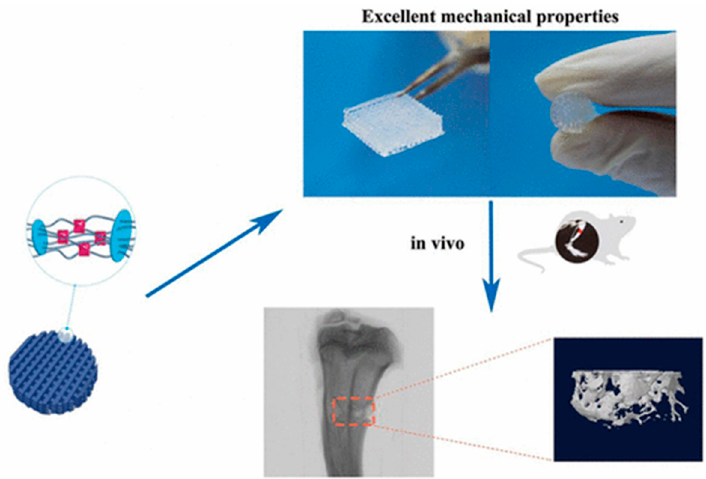
Figure 3. Supramolecular polymer/clay nanocomposite hydrogel scaffold for bone regeneration. Reprinted with permission from Reference [80]. Copyright 2017 American Chemical Society.